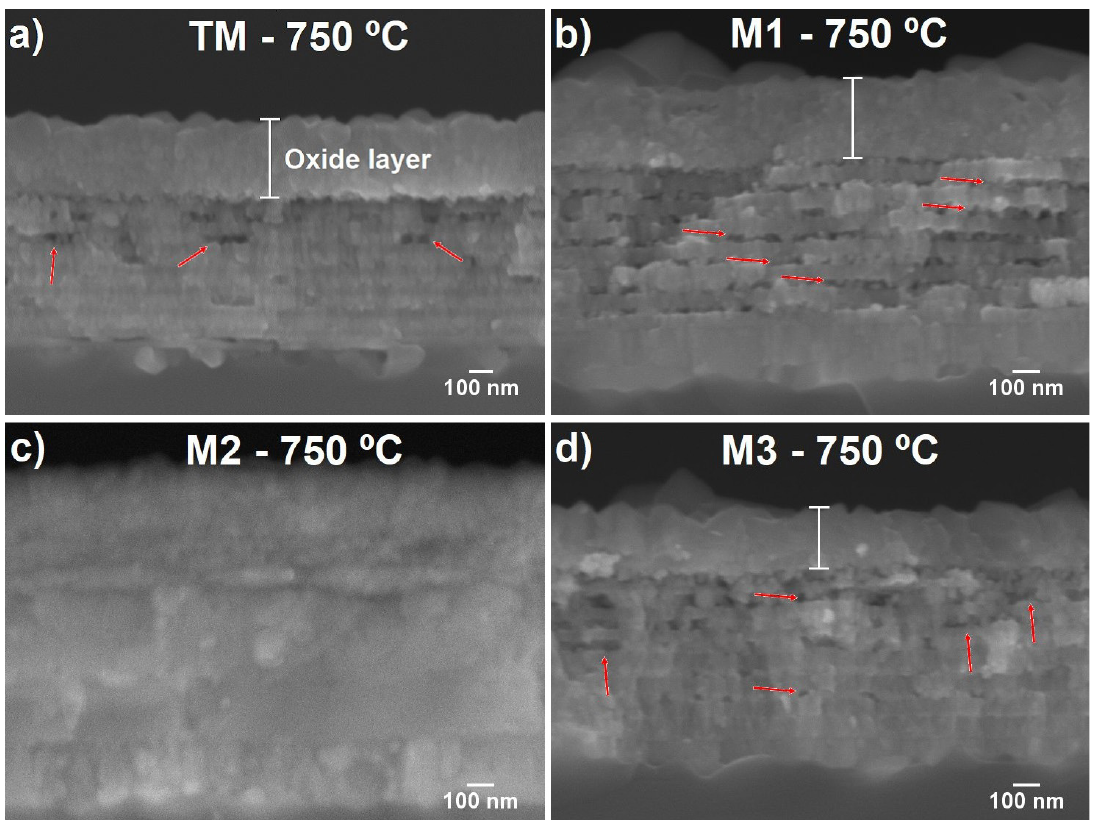
Figure 10. Cross-section SEM images with a magnification of 30000x acquired after oxidation tests at 750 ºC.